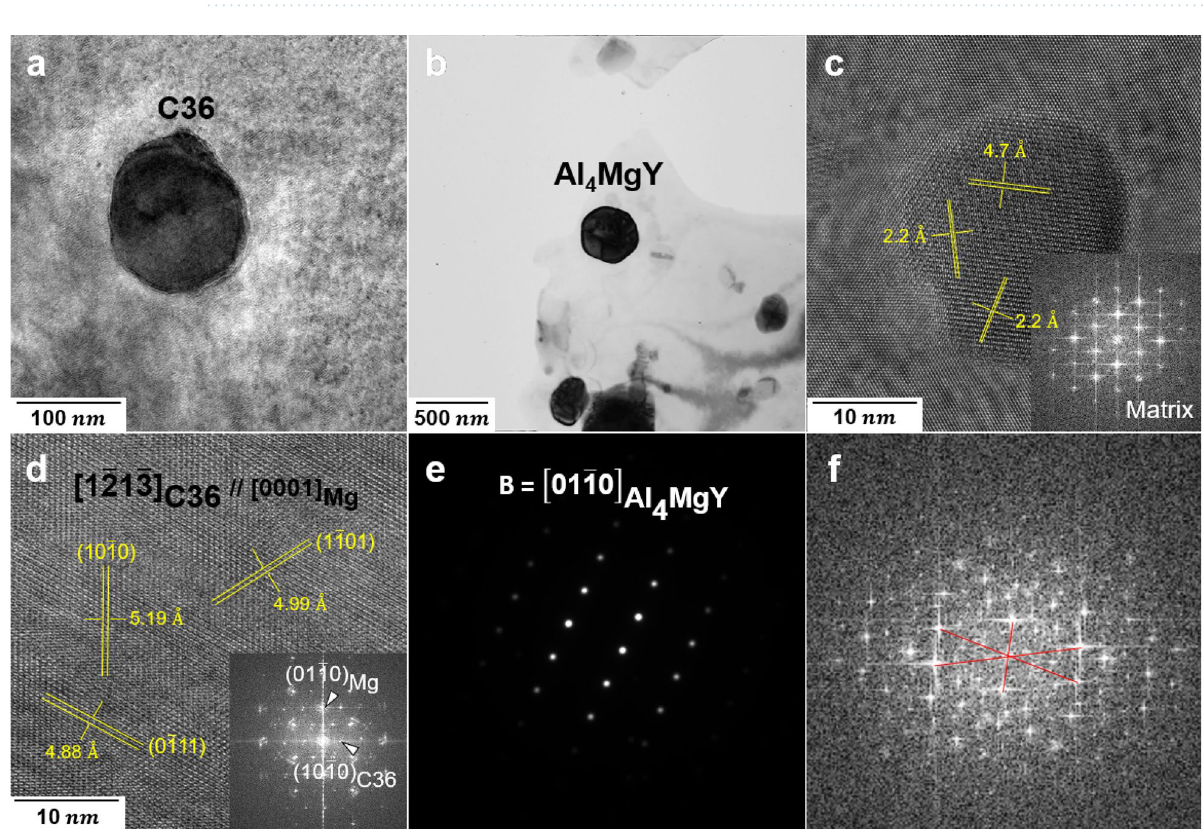
Figure 8. TEM images showing the several precipitates in the homogenized AX10, AXW100 and peak-aged AX10 alloy sheets. ( a , d ) HRTEM image and FFT pattern along [ 0001 ] Mg axis of C36 particle in the homogenized AX10 sheet, ( b , e ) TEM bright field image and SADP of Al 4 MgY particle in the homogenized AXW100 sheet, and ( c , f ) HRTEM image and FFT pattern of the particle in the peak-aged AX10